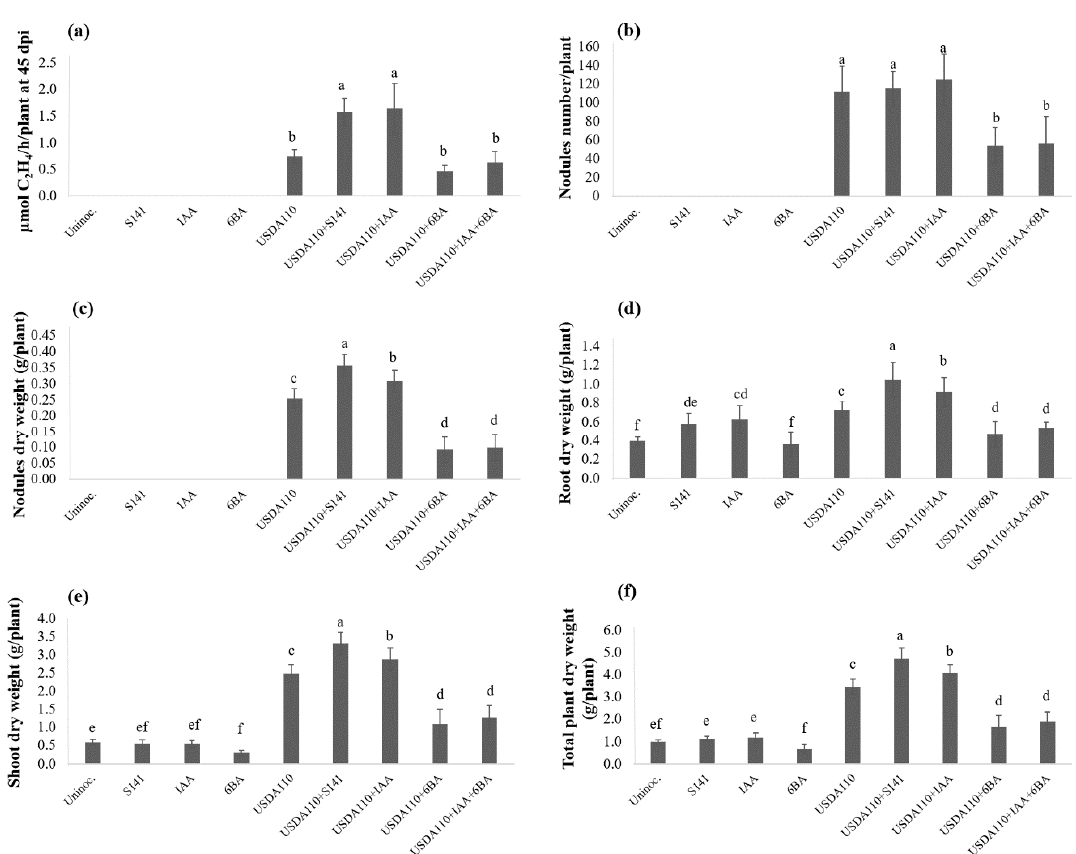
Figure 5. Plant growth parameters of soybean cultivar Chiang Mai 60 by co-inoculation with S141 and USDA110 compared with single inoculation supplemented with Indole-3-Acetic Acid and / or 6-Benzylaminopurine at 45 DAI: ( a ) nitrogenase activity was determined using the acetylene reduction assay; ( b ) nodule numbers per plant; ( c ) nodule dry weight; ( d ) root dry weight; ( e ) shoot dry weight; and ( f ) total plant dry weight. Significance at p ≤ 0.05 is indicated by mean standard error bars (n = 8 ).